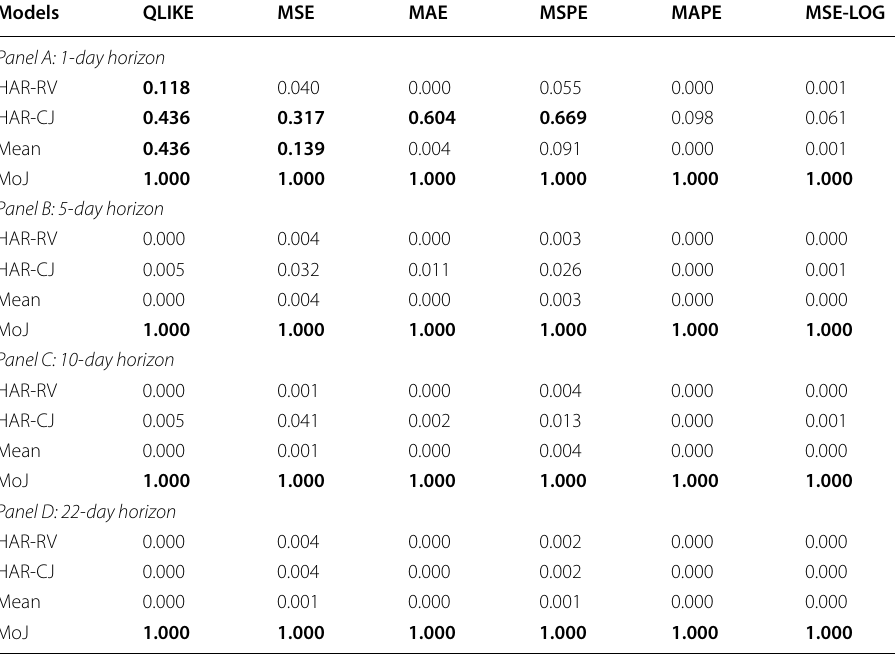
This table provides the MCS p values of the four used models. Particularly, the HAR-RV and HAR-CJ models used in this table are cast in standard deviation form. Panels A, B, C, and D report the corresponding results for 1-day, 5-day, 10-day, and 22-day horizons, respectively. The mean combination uses the equally weighted average (that is, simple mean) of the individual HAR-RV and HAR-CJ forecasts, while our MoJ strategy switches between the HAR-RV and HAR-CJ forecasts based on their relatively past forecasting performance. The past forecasting performance is evaluated by a 5-day look-back period. The six considered loss functions are QLIKE, MSE, MAE, MSPE, MAPE, and MSE-LOG. Bold numbers highlight important instances in which the corresponding model falls into the MCS with the 10% significance level